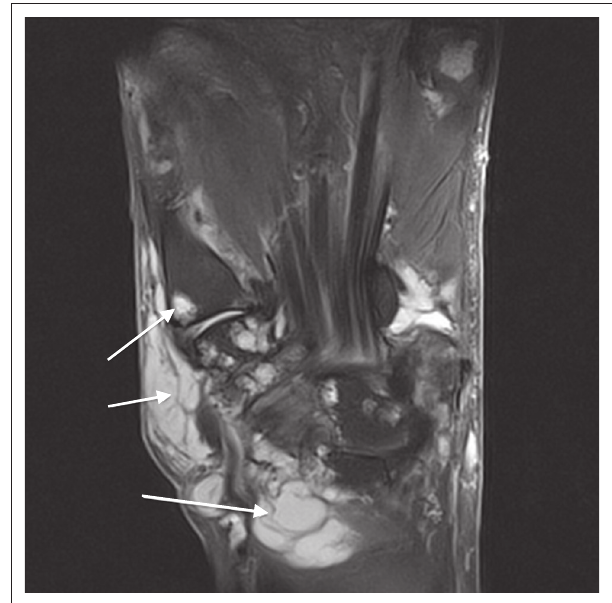
FIGURE 1: Axial PD fat-saturated image shows a cystic mass in the thenar eminence extending into the pronator quadratus and the radial epiphysis (white arrows). There is widespread flexor and extensor tenosynovitis (red arrow).